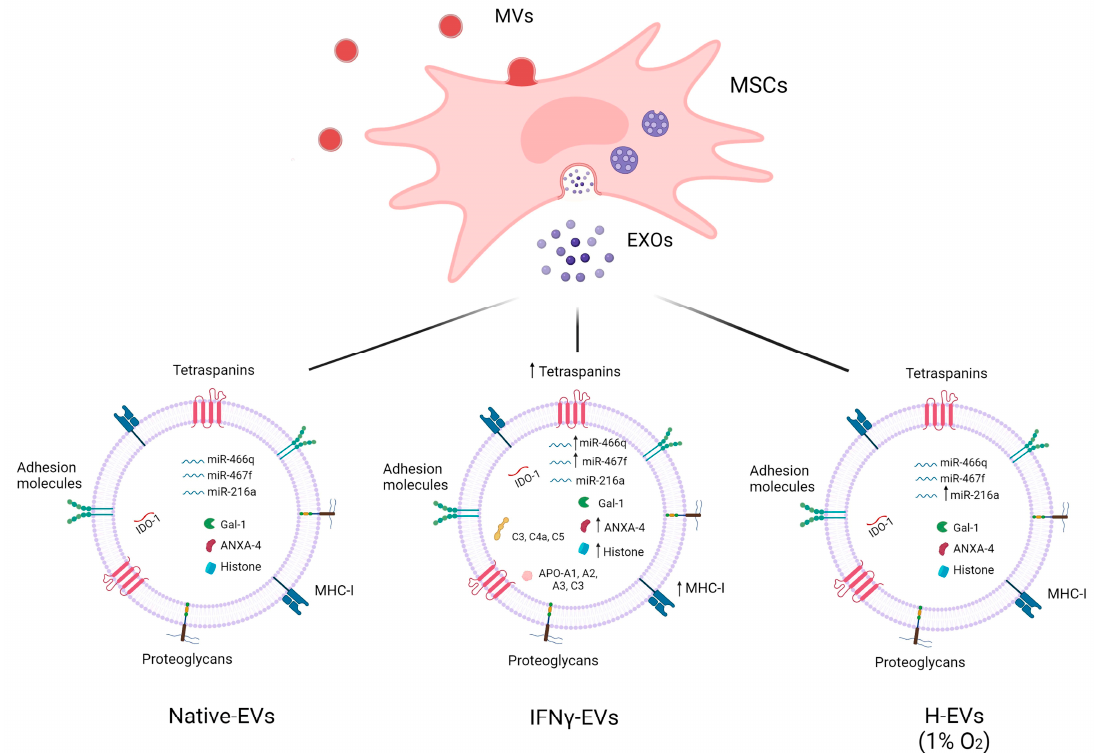
Figure 1. Molecular cargo of EVs from unstimulated (Native-EVs) and IFN- γ (IFN- γ -EVs and hypoxia (H-EVs)-primed MSCs. Treatment with IFN- γ and hypoxia implicates the high expression of specific immunomodulatory molecules, indicated by an upward arrow. Preconditioning of MSCs with IFN- γ causes an overexpression of indoleamine 2,3- dioxygenase 1 (IDO-1) mRNA, miR-467f, miR-466q, annexin A4 (ANXA4), and histones, while hypoxic conditions cause an increase in miR-216a. Moreover, IFN- γ -EVs contain several apolipoproteins and complement-related proteins. Created with BioRender.com.